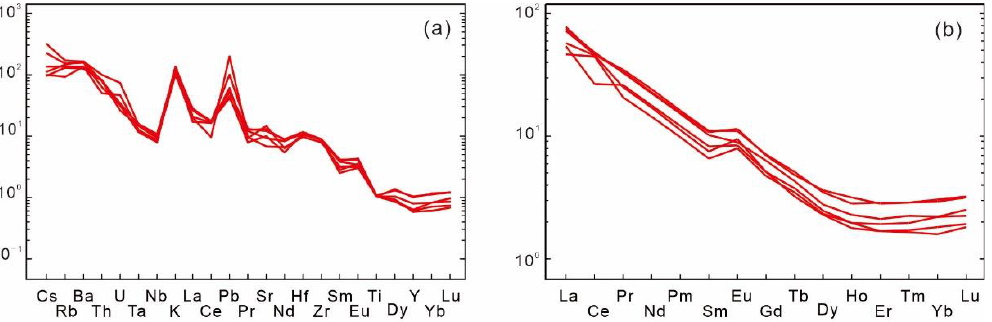
Figure 4. REE and trace elemental diagram of Zhaojinggou monzogranite in Inner Mongolia. ( a ) Primitive mantle-normalized trace elements spider diagram of Zhaojinggou monzogranites, Inner Mongolia. The values of normalization are from [28]. ( b ) Chondrite-normalized REE patterns diagram of Zhaojinggou monzogranite, Inner Mongolia (from [25]).